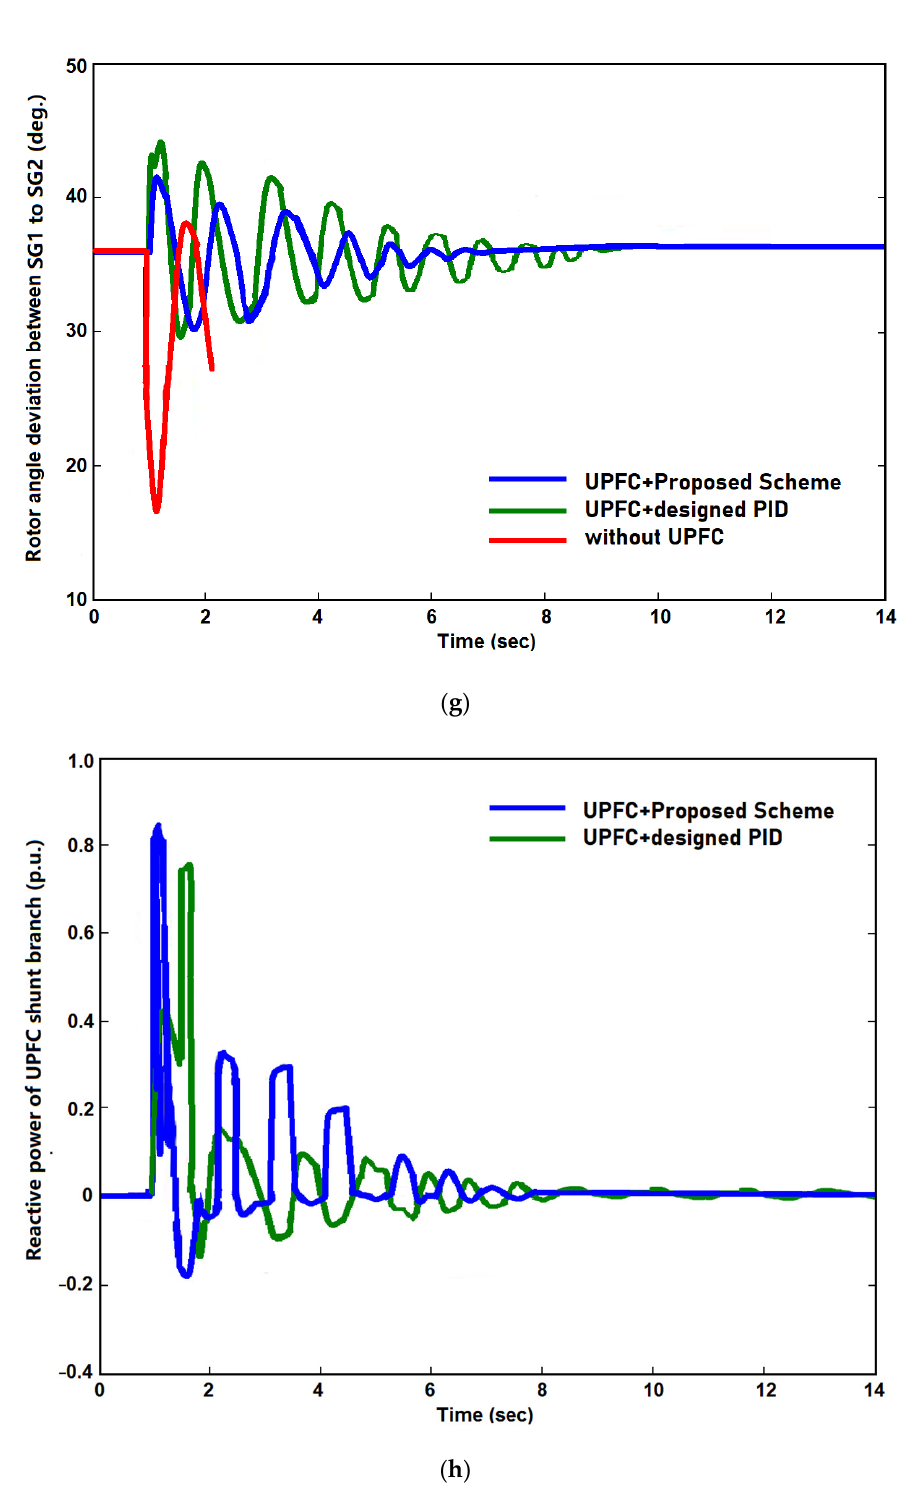
Figure 8. Transient responses of the proposed system for three phase short circuit fault for 0.5 s at the grid: ( a ) Active power response of Line 1, ( b ) Active power response of Line 2, ( c ) Voltage of Bus 4, ( d ) Terminal voltage of SG1, ( e ) Rotor speed of SG1, ( f ) Rotor speed of SG2, ( g ) Rotor angle devi- ation between SG1 to SG2, ( h ) Reactive power response of UPFC.